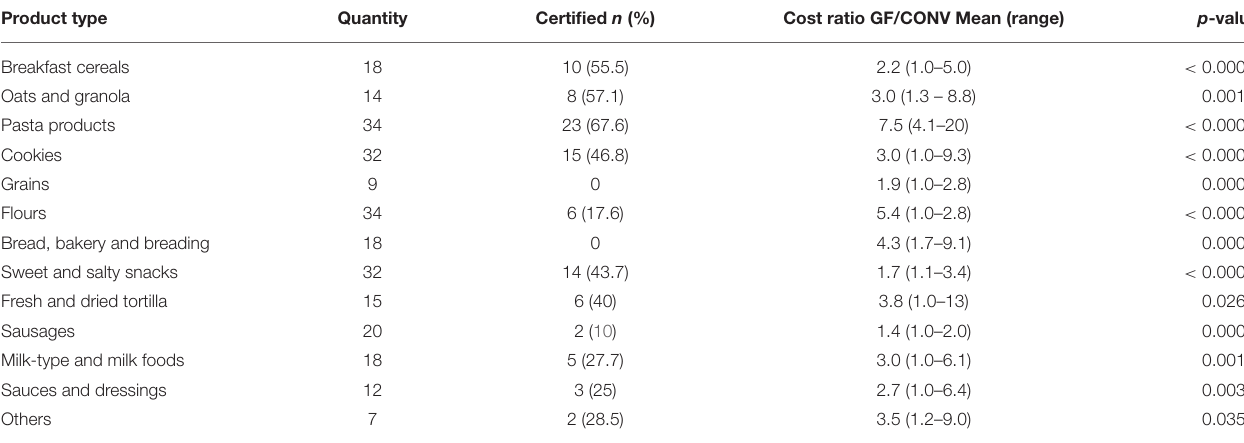
TABLE 1 | Gluten-Free (GF)-labeled product types, certification, and comparative costs with homologous conventional products ( n =